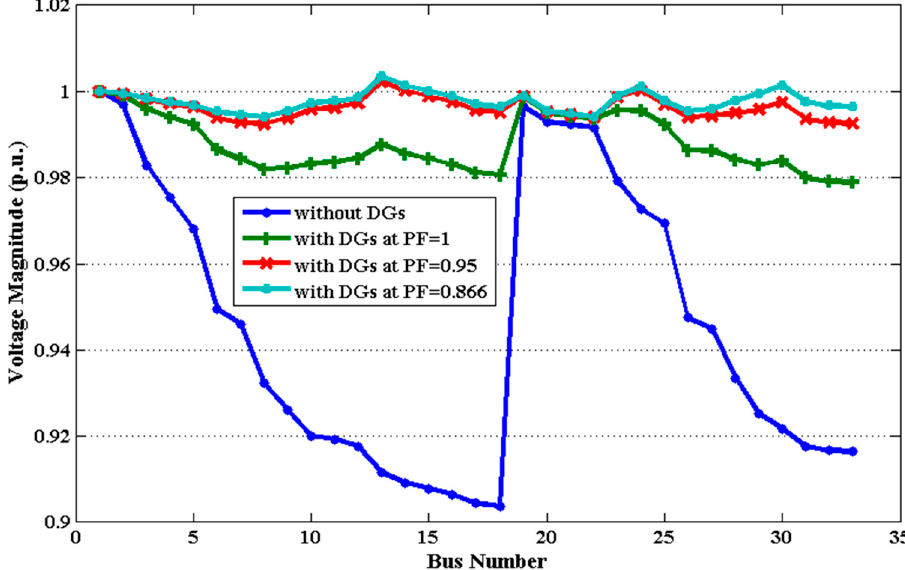
Figure 10. Voltage profile for Case 3 of the IEEE 33-bus system using QODELFA.